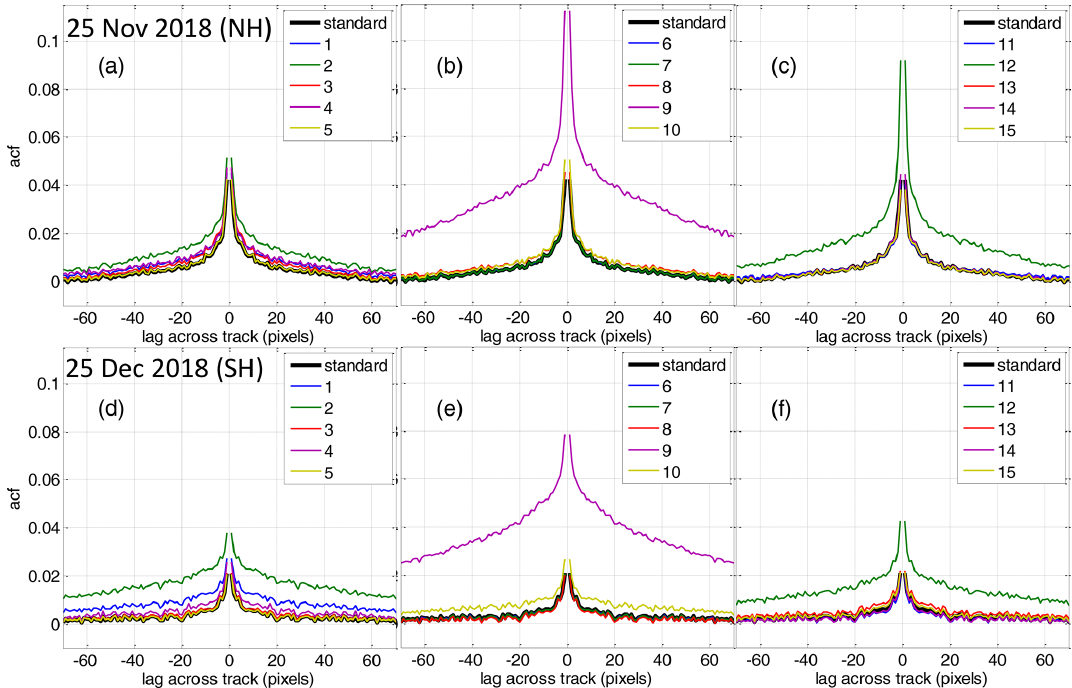
Figure B3. Autocorrelation coefficients calculated as in Fig. 2 but for different cases of the sensitivity study as a function of lags across track with a lag along track of 0. Result for 25 November 2018 (NH) (a–c) and 25 December 2018 (SH) (d–f)